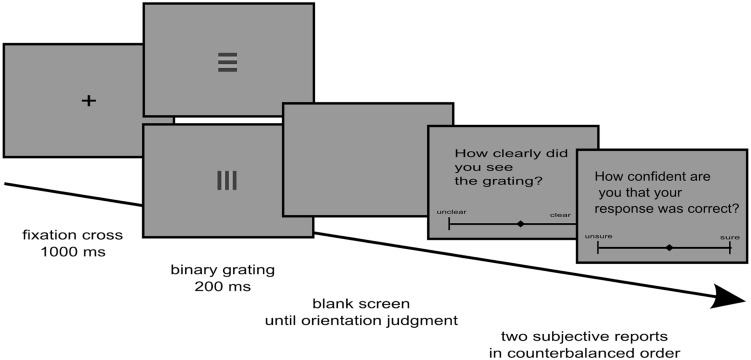
Trial structure.